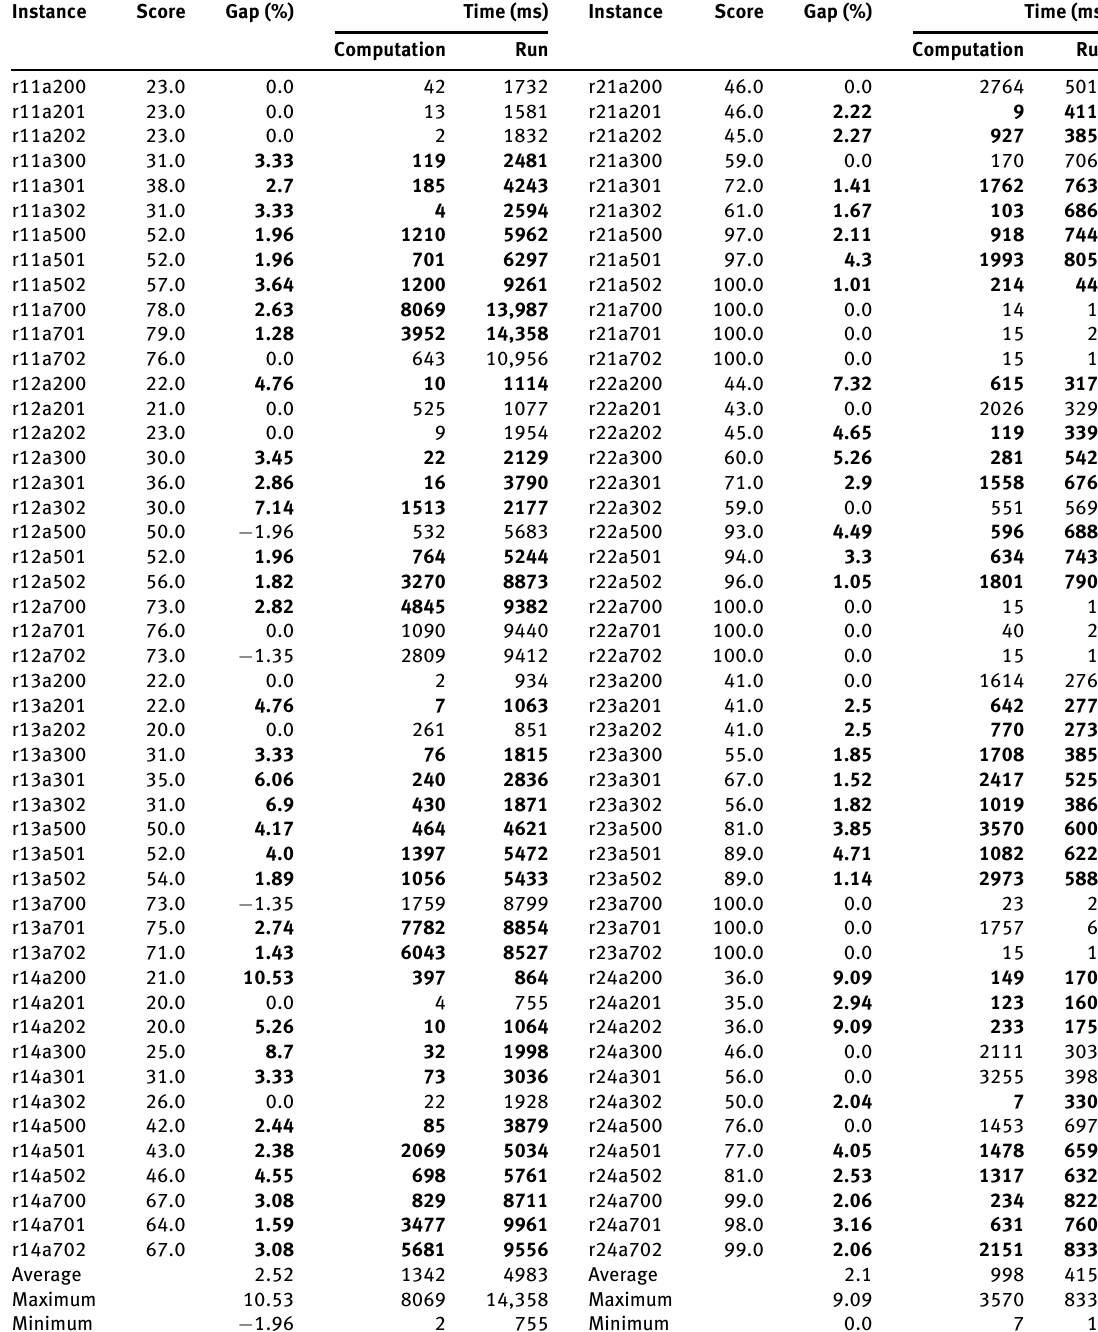
Table 2: Detailed Performance of Enhanced ILS (Median Run) Versus